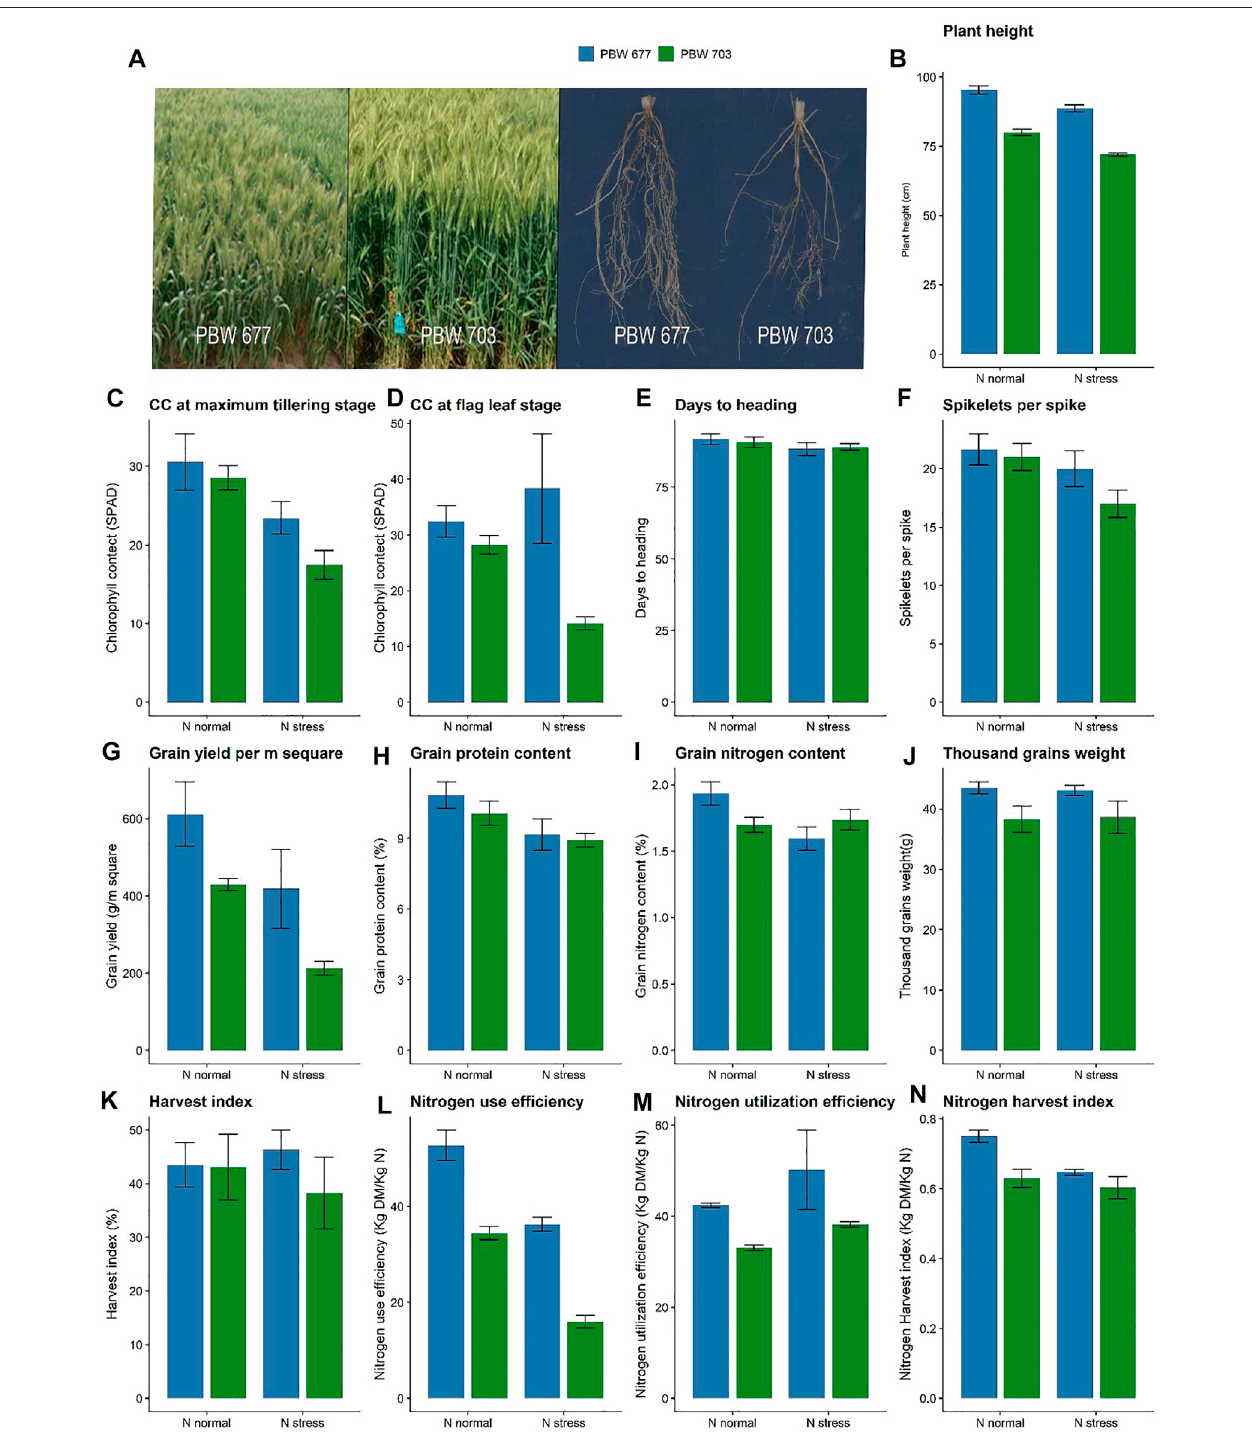
FIGURE1 | Growth performance,yield and nitrogen use ef fi ciencyparametersofwheatcultivarPBW 677and PBW 703grown under N + and N stress conditions. (A) Imagesofplantsshootandroots (B) Plantheight (C) Chlorophyllcontentandmaximumtilleringstage (D) Chlorophyllcontentat fl agleafstage (E) Daystoheading (F) Spikelets per spike (G) Grain yield (g/m2) (H) Grain protein content (I) Grain nitrogen content (J) Thousand grains weight (K) Harvest index (L) Nitrogen use ef fi ciency (NUE) (M) Nitrogen utilization ef fi ciency (NUtE) (N) Nitrogen harvest index.